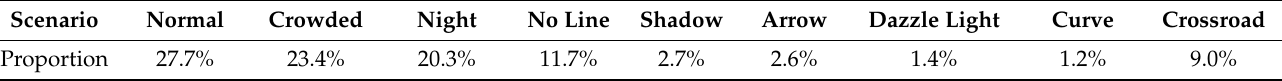
Table 3. The proportion of each scene on CULane